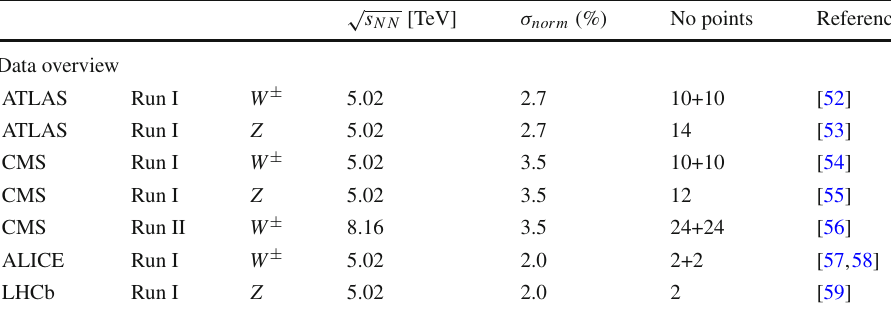
Table 1 The overview of the LHC W ± / Z data sets including the p Pb system with per nucleon center-of-mass enery √ s NN , experimental normalization uncertainty of the data σ norm arising from the luminosity uncertainty, number of data points, and